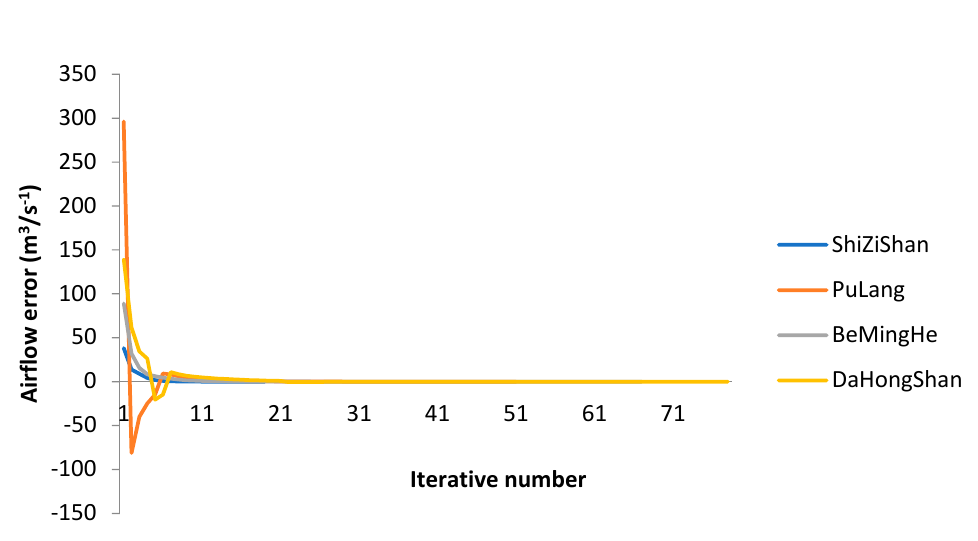
Figure 10. Solution convergence of four actual mines.